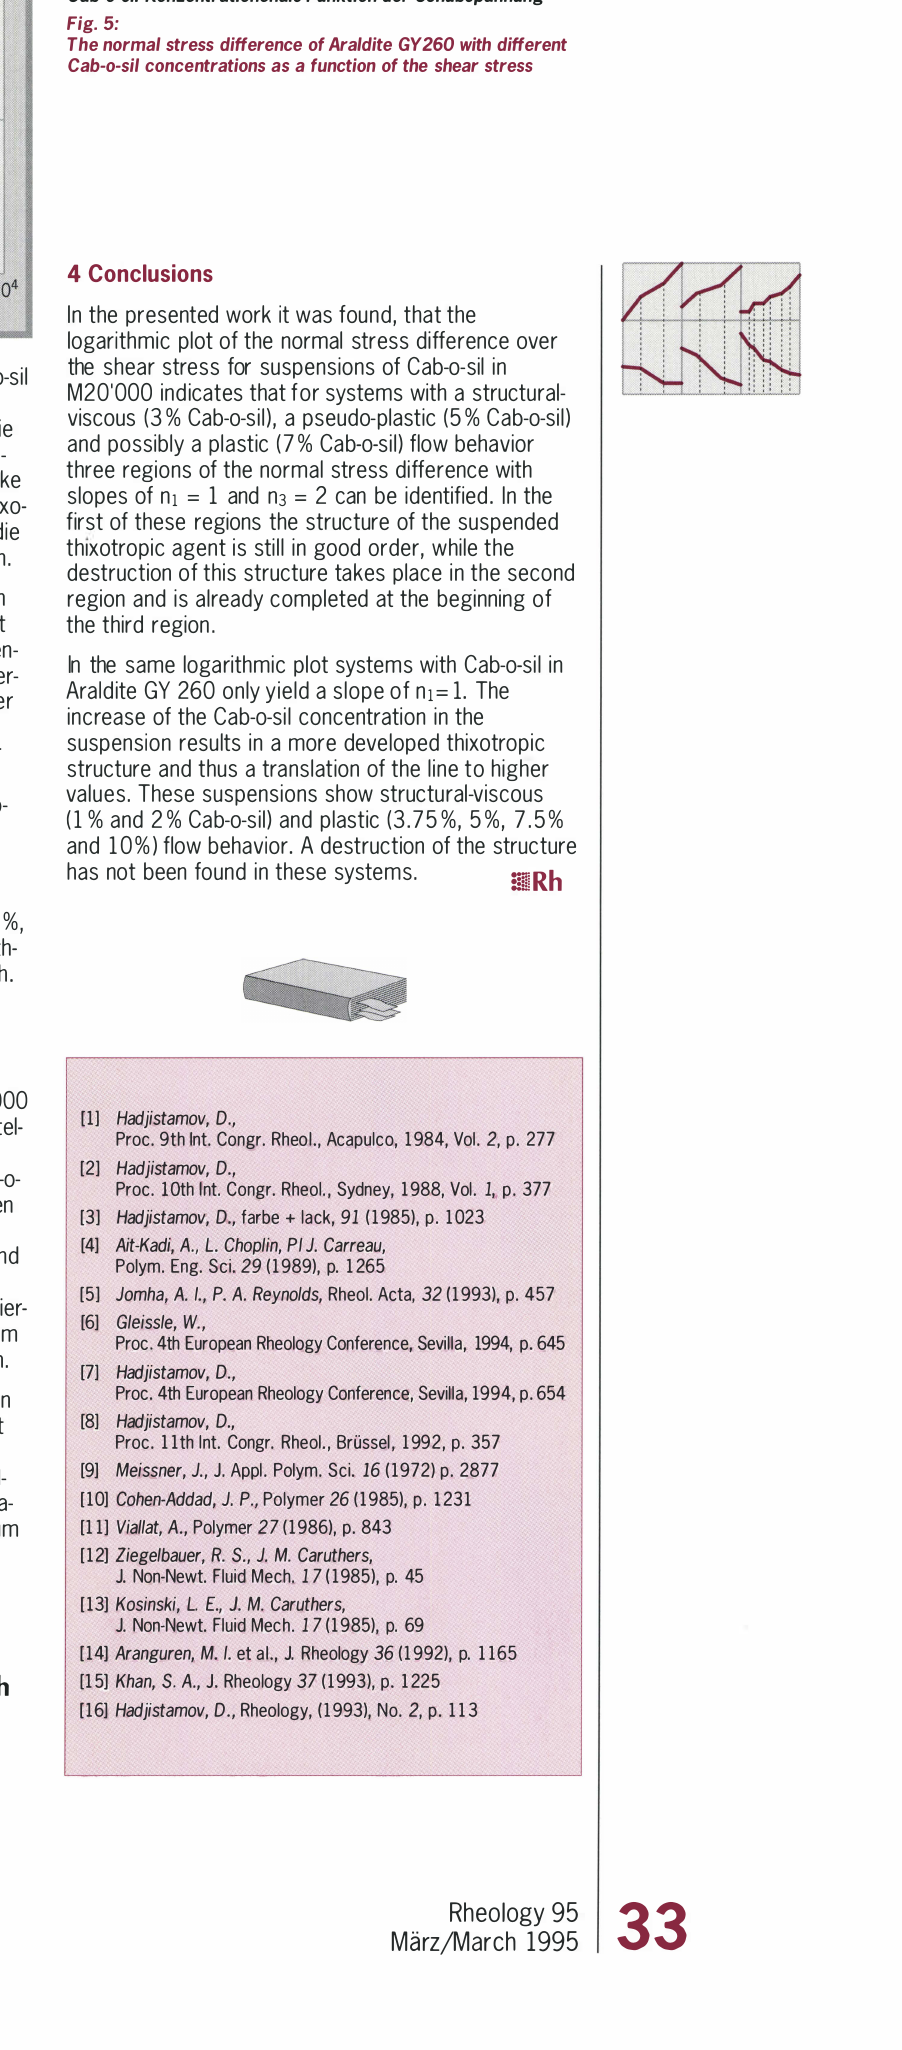
Fig. 5: The normal stress difference of Araldite GY260 with different Cab-o-sil concentrations as a function of the shear